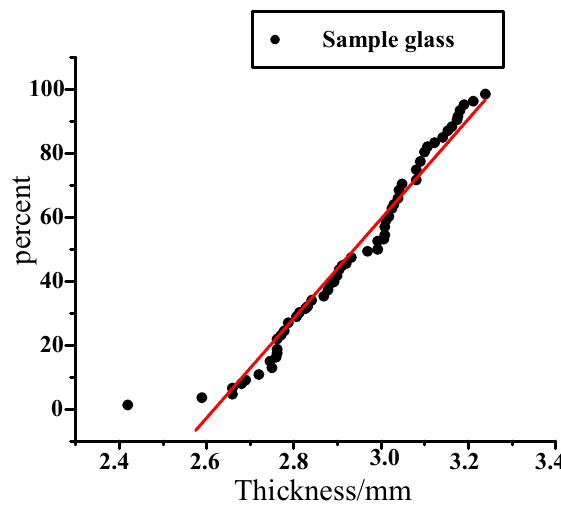
Figure 18. Sample data of window